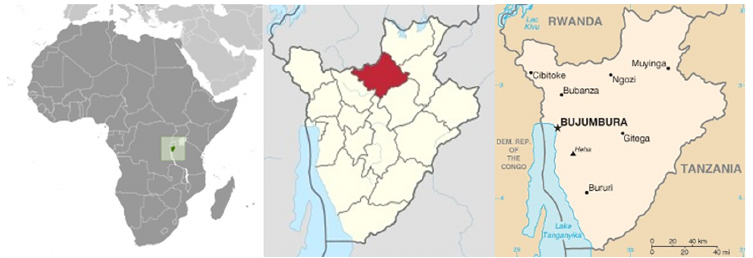
Fig 2. «Burundi location map» on the right, province of Ngozi in the center, and Ngozi city on the left. Images come from Wikipedia Commons available under license CC BY 3.0.